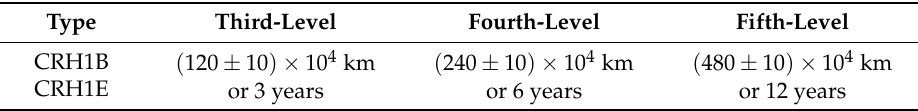
Table 1. Maintenance regulations for CRH1 series in China